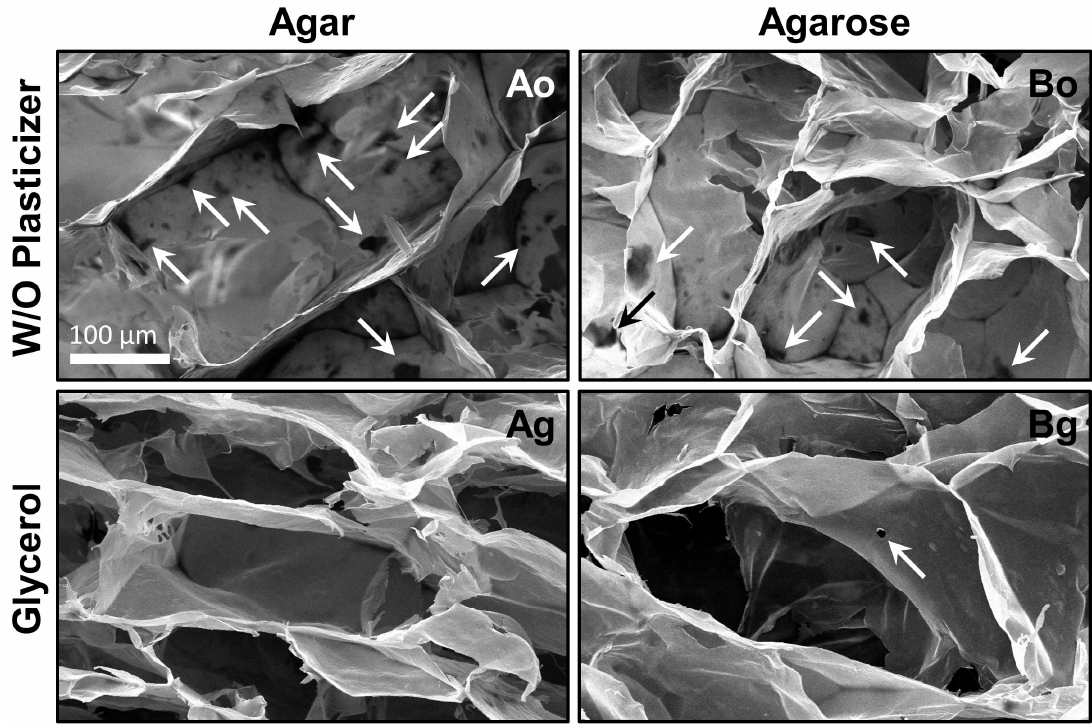
Figure 3. Microstructure of scaffolds (formulations Ao, Ag, Bo, and Bg). Arrows show the micro-holes.